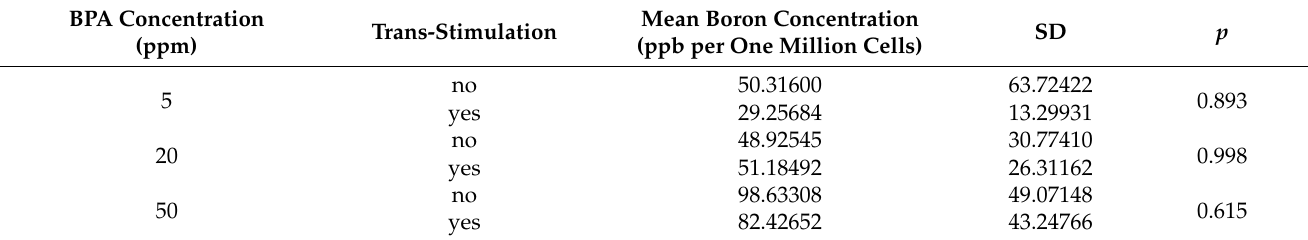
Table 1. Results of the ANOVA—no significant effect for trans-stimulation was seen. BPA Concentration